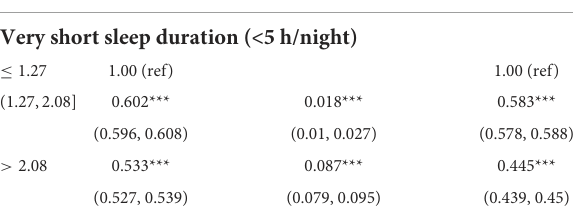
TABLE 3 Bootstrapped odds ratios (95% confidence intervals) of very short sleep (reference, 7–9 h/night) across tertiles of body weight-adjusted dietary ALA intake and differences between odds (95% bootstrapped percentile confidence intervals), stratified by gender, NHANES